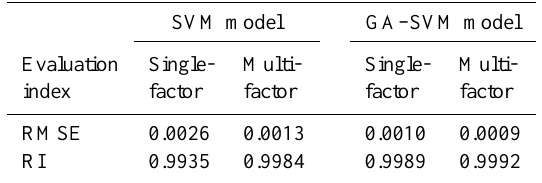
Table 1. The accuracy comparison of the SVM and GA–SVM mod- els for the